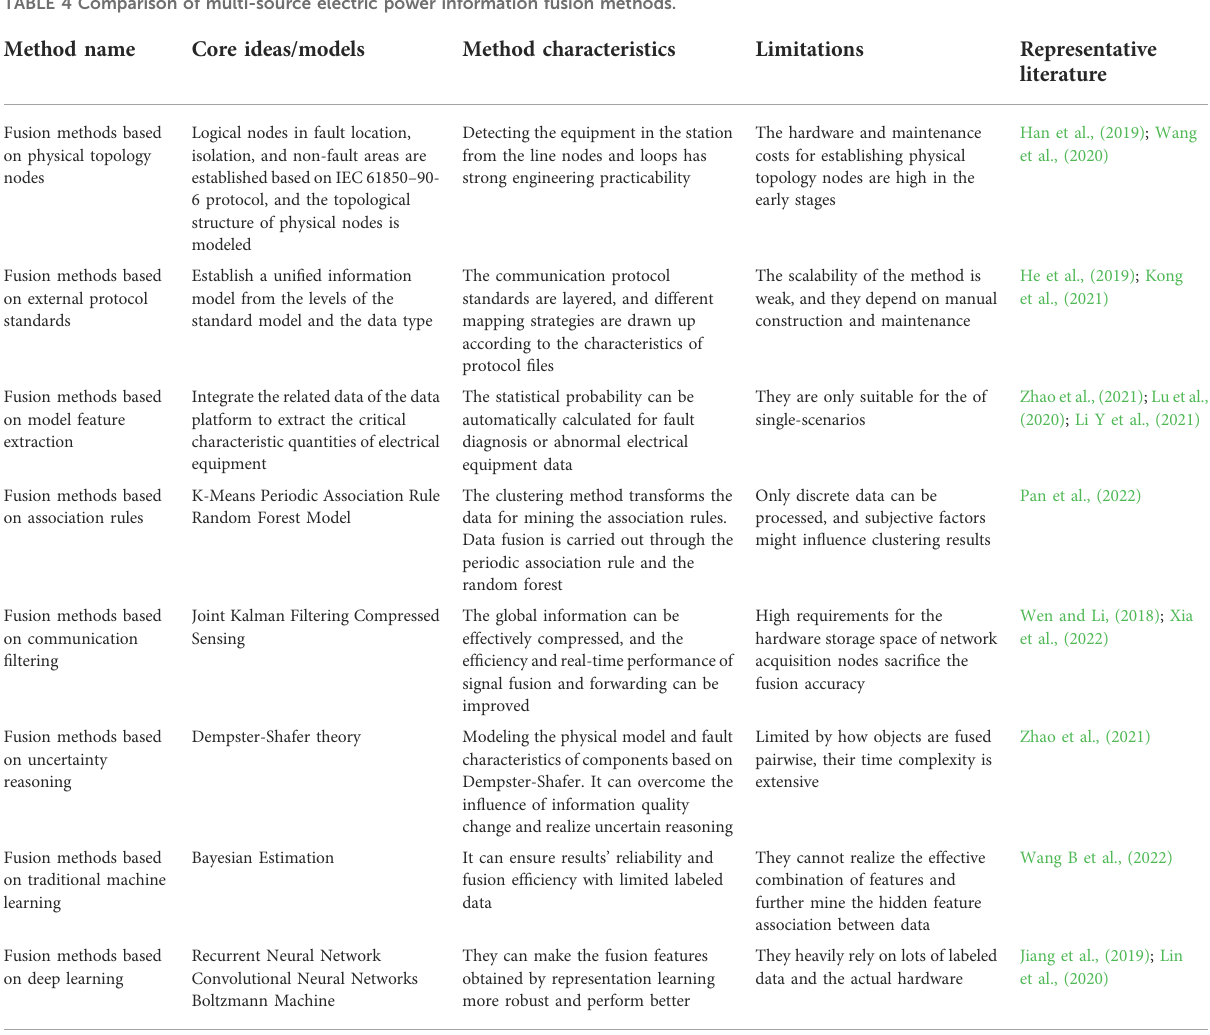
TABLE 4 Comparison of multi-source electric power information fusion